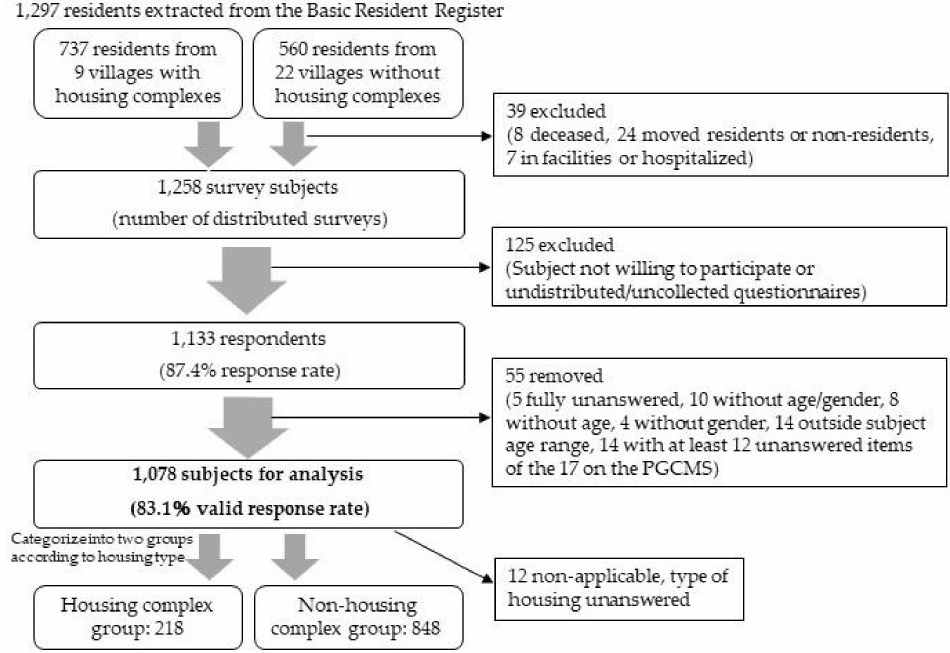
Figure 2. A flow chart illustrating the survey